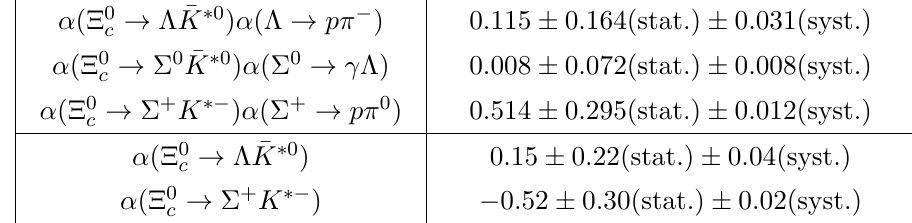
Table 6 . The values of asymmetry parameters, where the uncertainties are statistical and system-